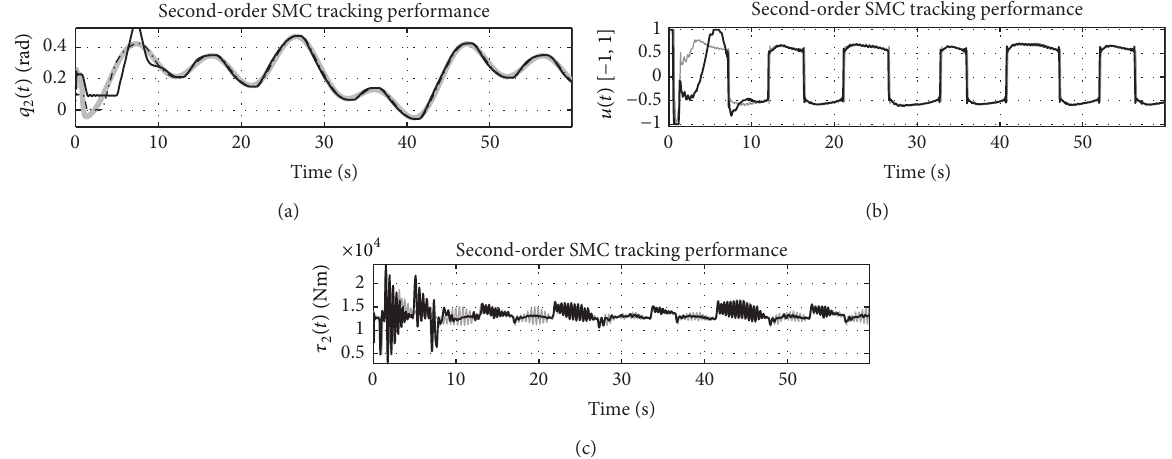
Figure 13: Experimental results of tracking performance with a second-order SMC. (a) Angular link displacement in radians . The bold signal shows the results applying the state-dependent method (48), thestriped signal shows resultswith the original formula (40), and the gray signal is the reference trajectory. (b) Control input . The bold signal shows the results applying the state-dependent method (48) and the gray signal shows results with the original formula (40). (c) Computed torque from pressure measurements . The bold signal shows the results applying the state-dependent method (48) and the gray signal shows results with the original formula (40).